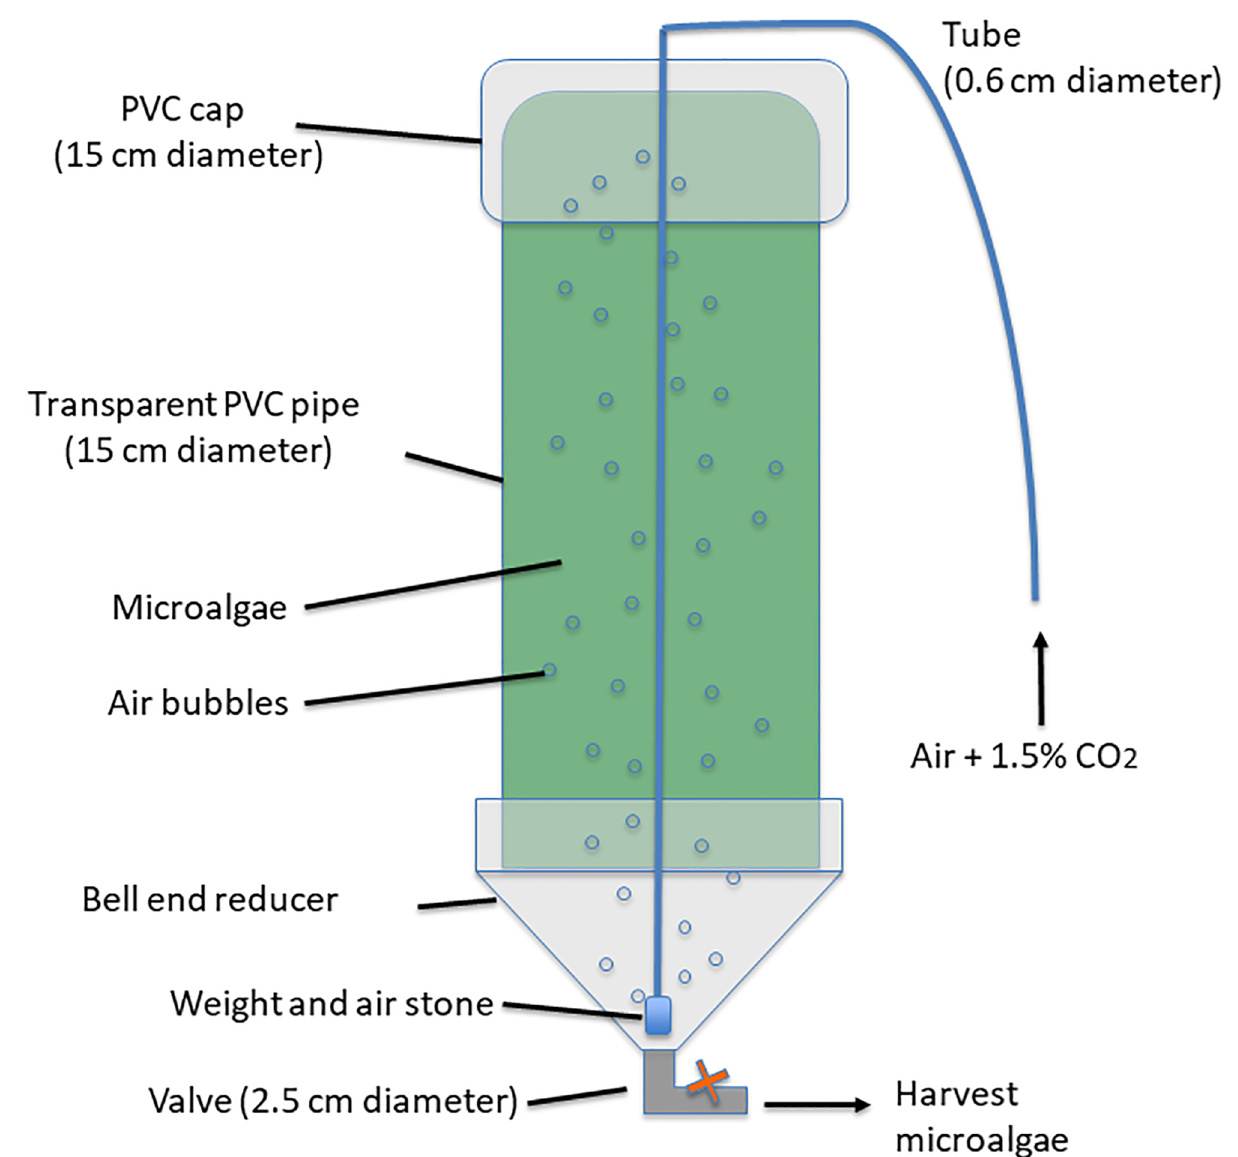
Fig 1. Schematic diagram of the photobioreactor developed in this study.